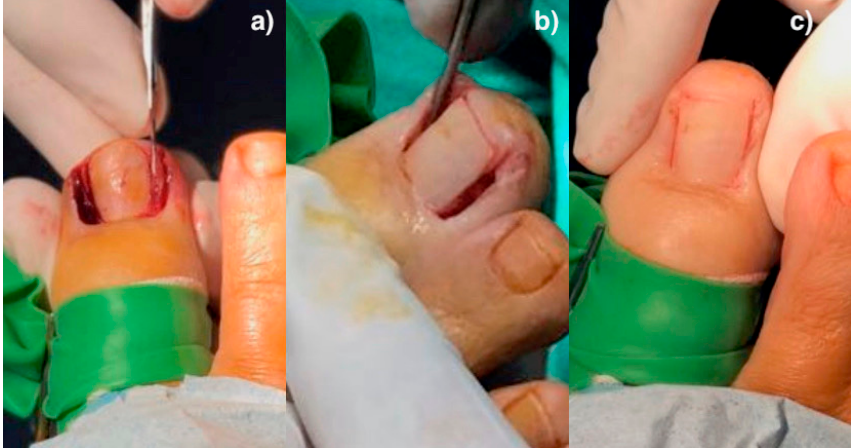
Figure 1. Aesthetic reconstruction: ( a ) Subeponychial wedge excision; ( b ) curettage of the matrix zone and the nail bed; ( c ) coapting the folds.